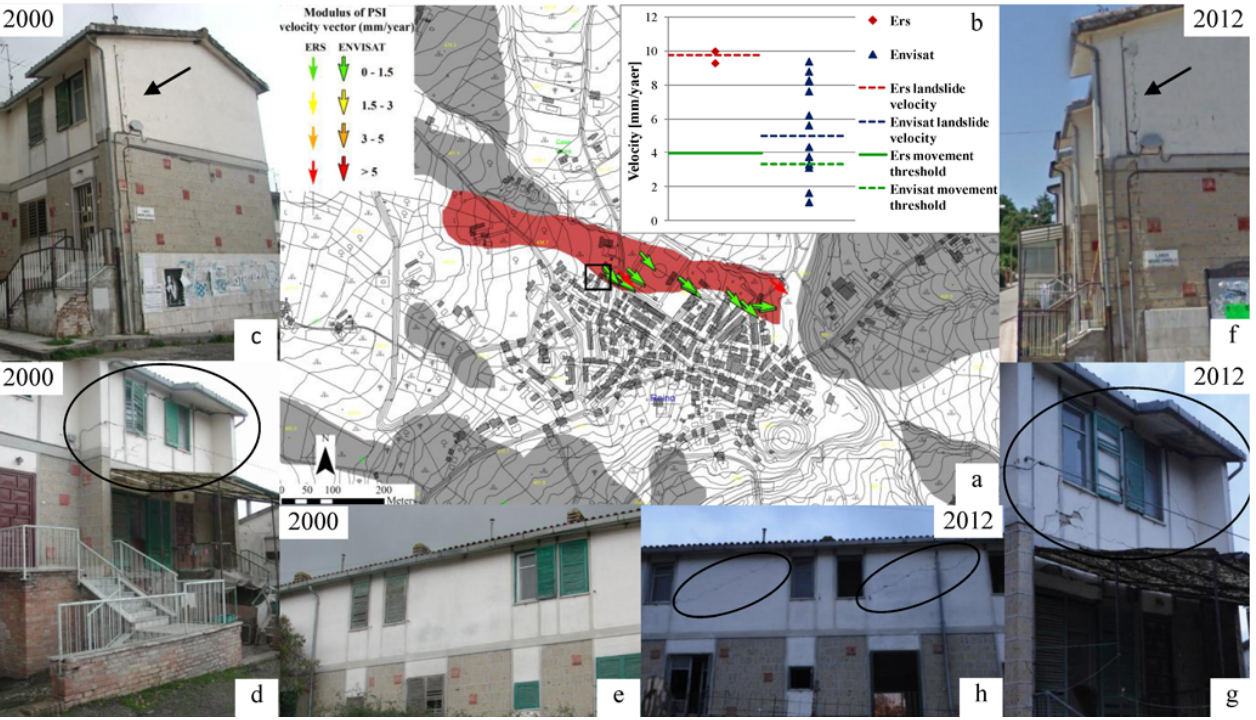
Fig. 23. A dormant earth flow in the municipality of Reino (Benevento Province): (a) the inventory map with ERS/ENVISAT PS velocity vectors; (b) diagrams of the ERS/ENVISAT velocity values for the PS located within the landslide boundaries and indication of both the computed landslide velocity and the computed movement threshold; three different views of row-houses located on the middle boundary of the landslide (see the black square in a ) with highlight on the damage recorded in the surveys dated 2000 (c–e) and 2012 (f–h)